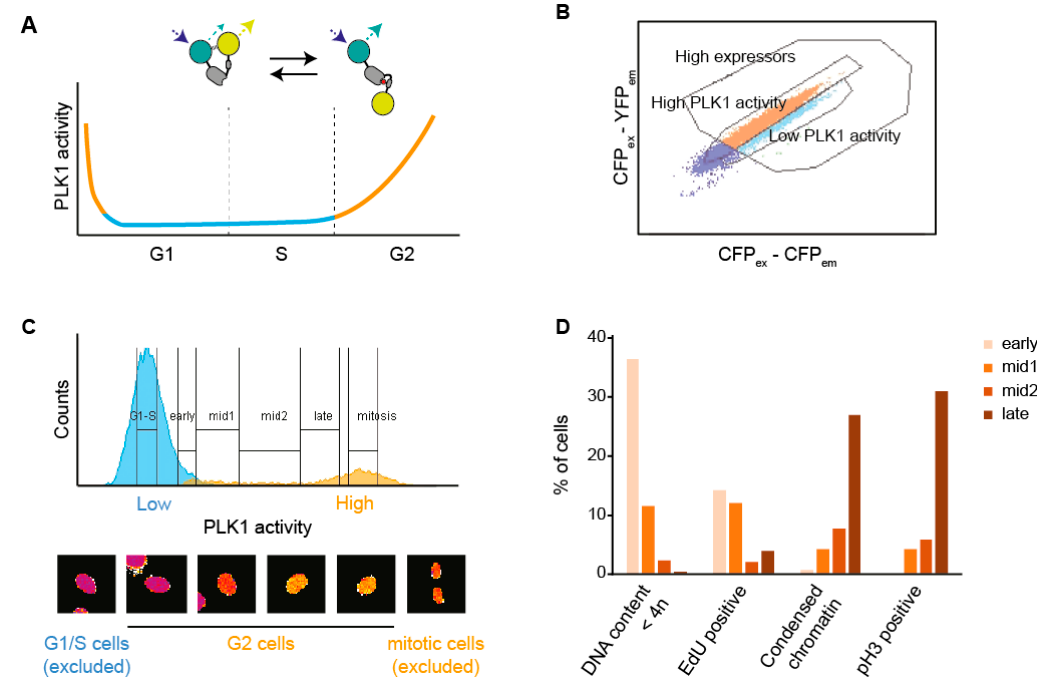
Figure 1. FRET-activated cell sorting (FRACS) is used to collect cells with di ff erent levels of PLK1 activity. ( A ) Schema of the FRET probe used throughout the experiments. The probe contains a consensus motif for PLK1 in the linker region between the two FRET fluorophores. The conformational change induced by phosphorylation results in a decreased FRET ratio. The graph represents the levels of PLK1 activity that are associated with the various phases of the cell cycle. ( B ) Flow cytometry was used to visualize an asynchronous population of RPE1 cells expressing the PLK1 FRET probe depicted in ( A ). Cells expressing the probe at high level were selected to ensure a robust readout. ( C ) Inverted FRET ratio (PLK1 activity) of an asynchronous population of cells measured by flow cytometry. Based on the knowledge that PLK1 activity increases during G2 phase, we were able to discriminate and collect fractions of G1-S (no / low PLK1 activity, cyan peak), early-G2 (low PLK1 activity), mid-G2 (medium PLK1 activity) and late-G2 (high PLK1 activity) cells. Representative pictures of cells belonging to each fraction are shown below the histogram. False coloring was used to render the changes in PLK1 activity (purple = low, yellow = high). ( D ) Asynchronously-growing RPE1 cells were pulsed 1 h with EdU prior to be sorted based on their PLK1 activity level. Right after FACS, the di ff erent populations of cells were fixed and prepared for microscopy analysis. At least 50 cells were quantified to assess their DNA content, the degree of DNA condensation, phosphorylation of Histone H3 and the presence of EdU. Representative pictures are shown in Figure